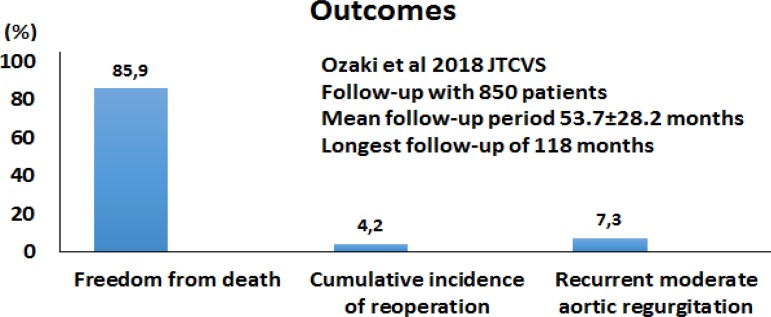
Results published by Ozaki et al.[5].